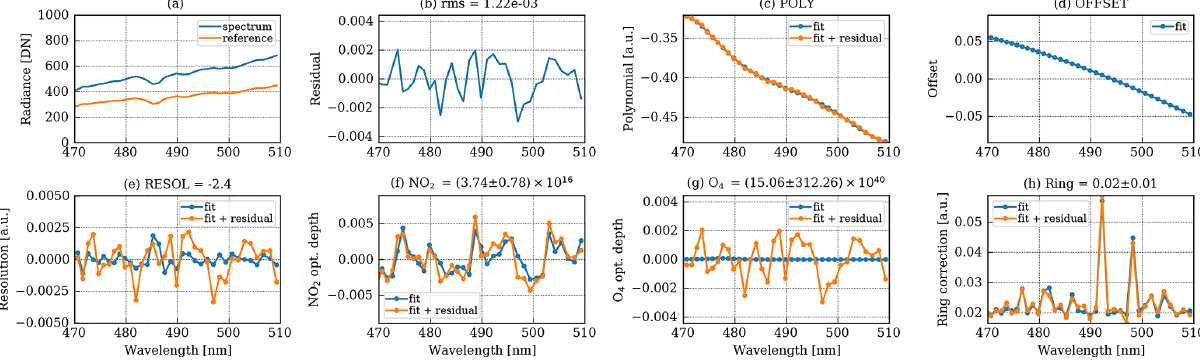
Figure 5. Example of DOAS retrieval for APEX stripe no. 2 inside the NO 2 plume of the Heizkraftwerk Süd power plant at across- and along- track positions of 42 and 314, respectively: (a) APEX measurement spectrum and reference spectrum, (b) residual, (c) fitted polynomial, (d) fitted offset, (e) resolution cross section, (f) NO 2 optical depth, (g) O 4 optical depth, and (h) Ring pseudo cross